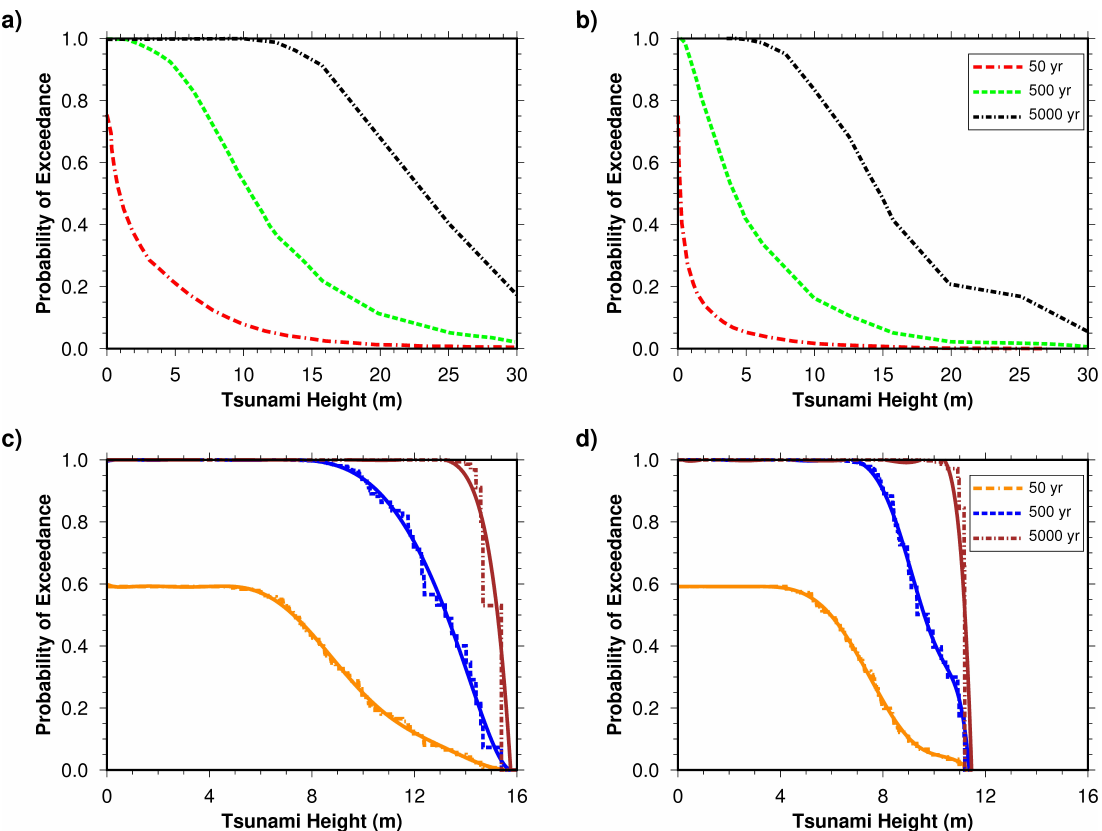
Figure 9. Tsunami hazard curves by Hoechner et al. [116] ( a , b ) and Rashidi et al. [56] ( c , d ) for coastlines of Iran-Pakistan (left panel) and Oman (right